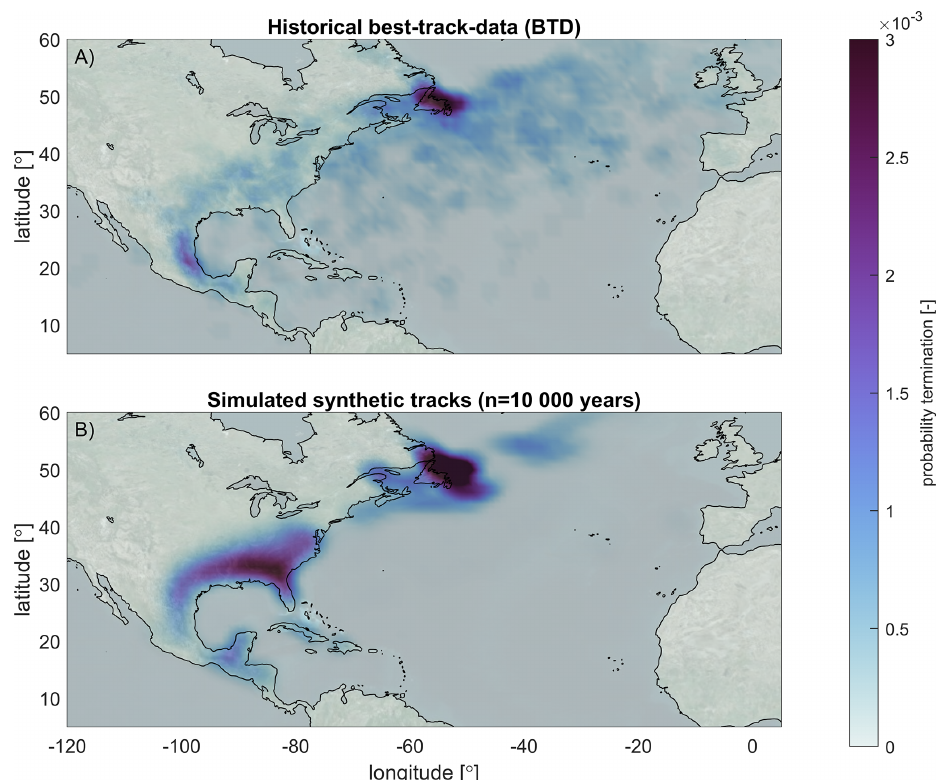
Figure 9. Termination probability of historical BTD (a) and simulated TCs with TCWiSE (b) for the NA basin. Occurrence is based on TCs within 200km per grid cell for historical TCs from 1886–2019 and 10000 years of simulated events. © Microsoft Bing Maps.